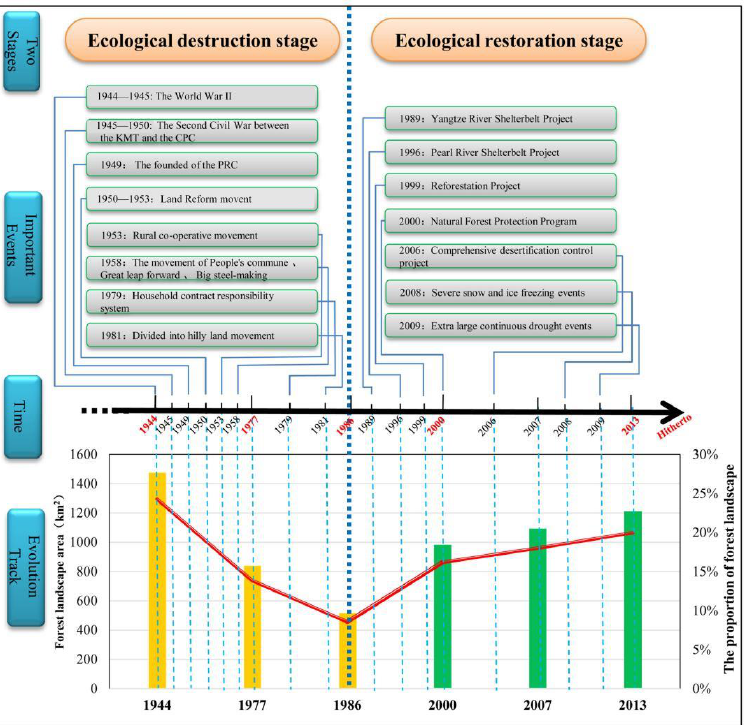
Figure 5. The evolution process of forest landscape and important historical events related to it. (We constructed this figure using WPS office (https://platform.wps.cn/) (accessed on 30 December 2021)).